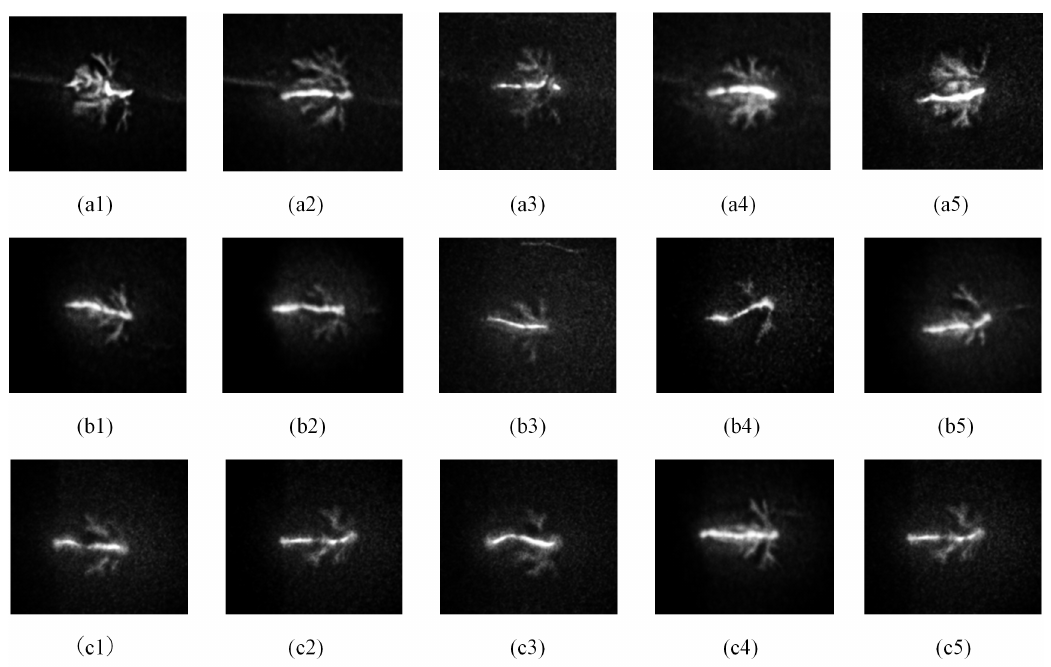
Figure 4. The streamer morphology of pure transformer oil and nano-liquids shot by high-speed camera. ( a1 – a5 ) pure transformer oil, ( b1 – b5 ) TiO 2 nano-liquids, ( c1 – c5 ) Al 2 O 3 nano-liquids.